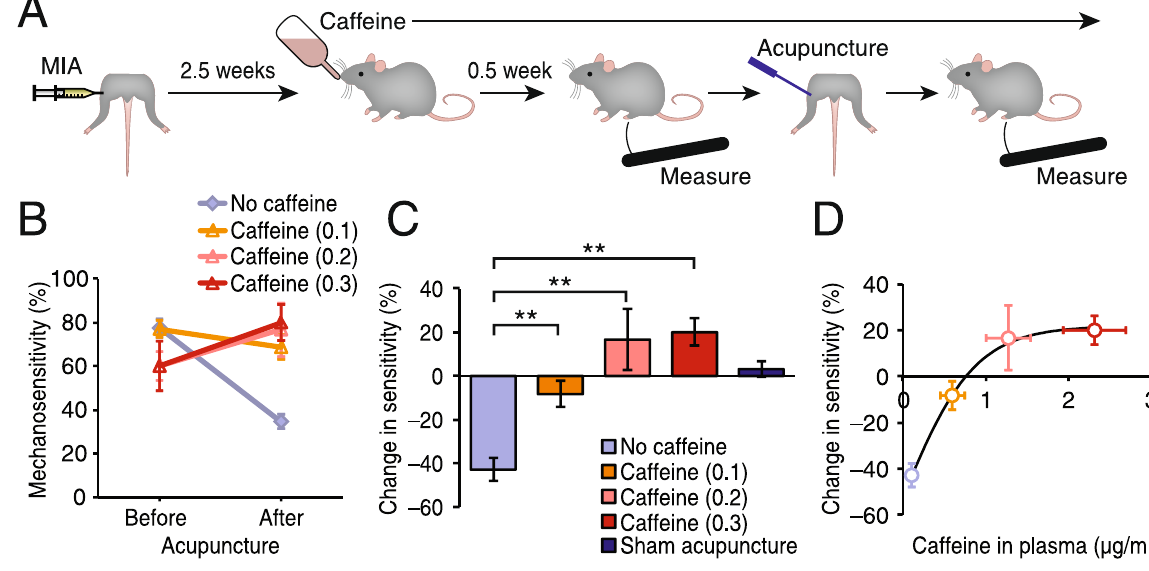
Figure 2. Caffeine interferes with the effect of acupuncture on chronic osteoarthritis pain. ( A ) Schematic diagram illustrating the major steps of the experimental procedure in the chronic joint pain model. Pain was induced by monosodium iodoacetate (MIA) in a knee joint 3 weeks prior to the measurement of mechanical sensitivity with von Frey filament. After pain induction (2.5 weeks), mice were acclimated to drinking water containing caffeine for 3–4 days. Mechanical sensitivity was measured twice, before and after acupuncture treatment given to the affected hind leg in awake mice. ( B ) Comparison of mechanical sensitivity before and after acupuncture treatment. Mice that received normal drinking water (No caffeine, blue grey) showed significant decrease in sensitivity following acupuncture treatment, whereas such reduction in sensitivity was absent in mice drinking caffeine-containing water (0.1 mg/ml, orange; 0.2 mg/ml, pink; 0.3 mg/ml, red). Sham acupuncture treatment did not alter the mechanical sensitivity (dark blue). N = 5–14. ( C ) Summary histogram of changes in mechanical sensitivity by acupuncture that are shown in panel B. Similar to the acute pain model, acupuncture decreased the mechanical sensitivity of mice in the no caffeine group in the chronic osteoarthritis pain model. The anti-nociceptive effect of acupuncture was reversed when the mice were administered caffeine. Sham acupuncture did not alter the mechanosensitivity. N = 5–16. ** p < 0.01. (D) Dose-response histogram correlating plasma levels of caffeine and acupuncture-induced changes in mechanosensitivity. Displayed are means ± S.E.M. in B – D